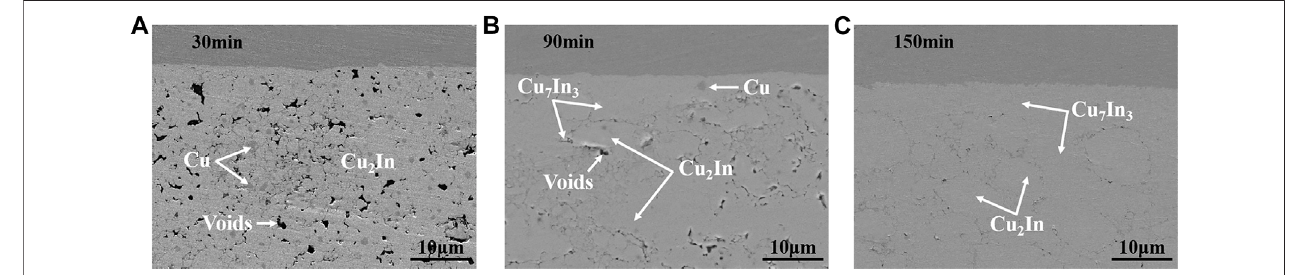
FIGURE 7 | The microstructure of bonding layer with different holding times at 320 ° C: (A) 30 min, (B) 90 min and (C) 150 min.